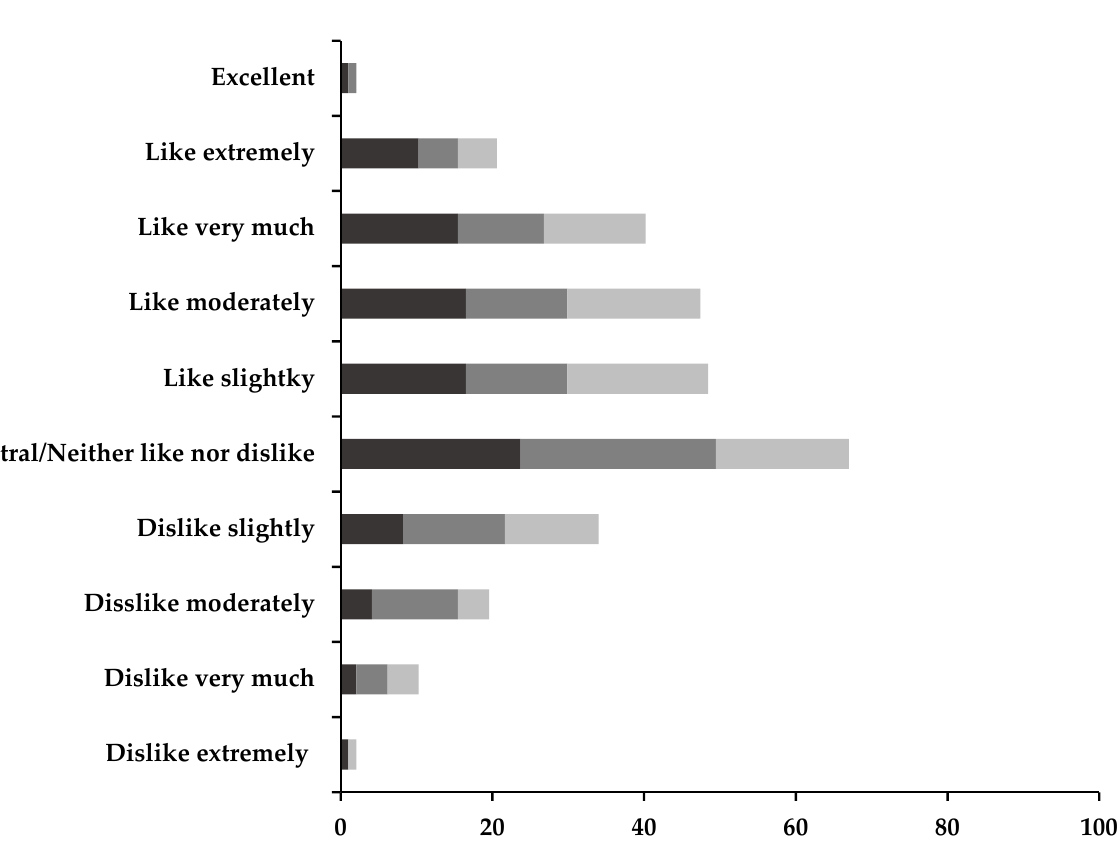
Figure 6. Distribution of consumer acceptance scores for three candy bars. Average acceptance values scores awarded by 97 testers expressed in %.